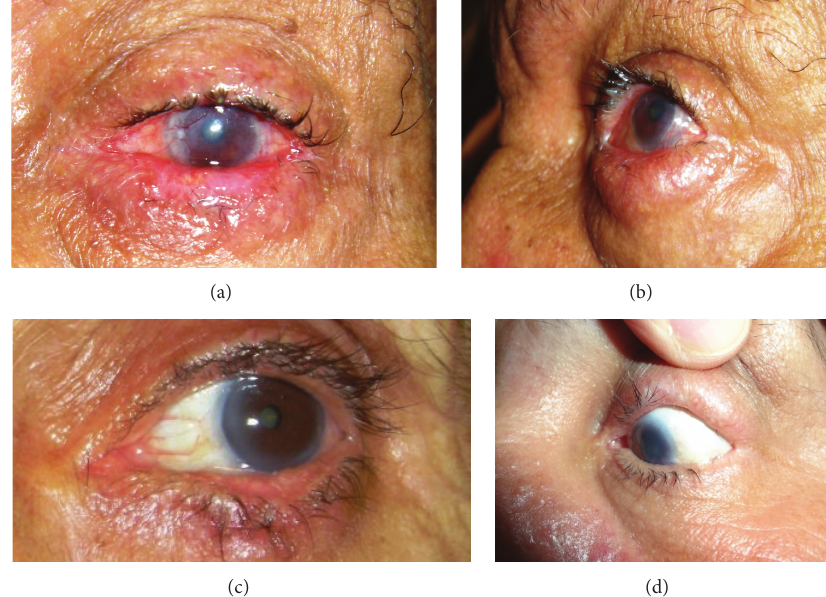
Figure 3: Postoperative outcomes. (a) Thickened lower lid margin 3 wk. postoperatively. (b) The lower lid of the same patient showing return of the anterior lamella to its place, no rubbing lashes with soft appearance of the lid margin. (c) Persistent recession of the anterior lamella. (d) Upper lid temporal madarosis following ALR.